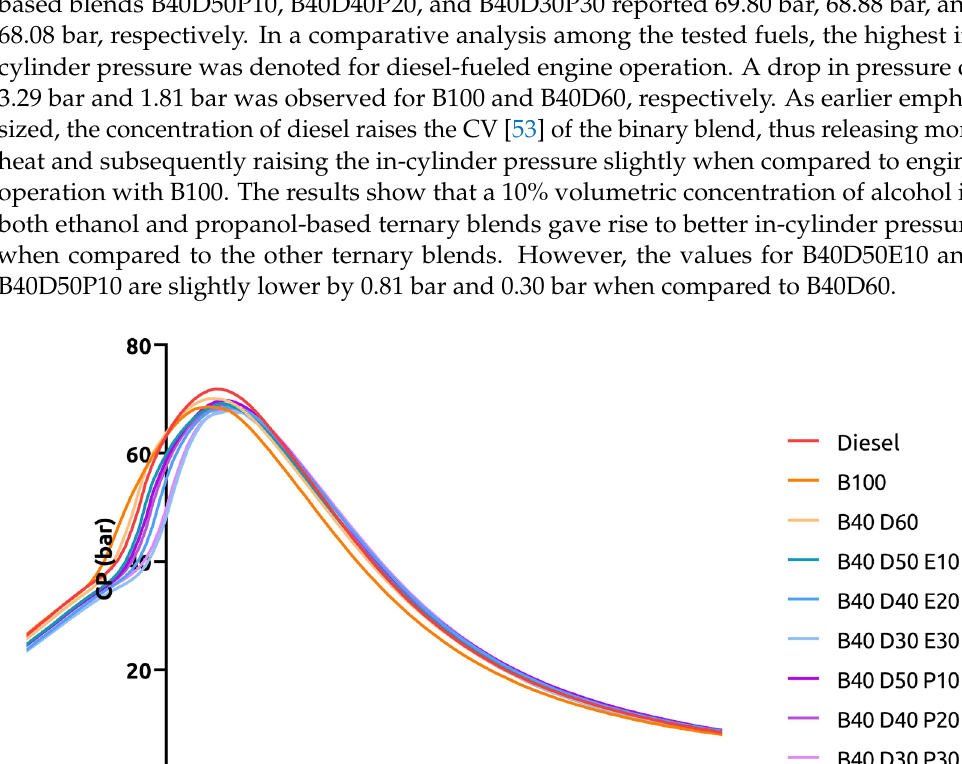
Figure 6. Heat release rate for tested fuels at full engine load.